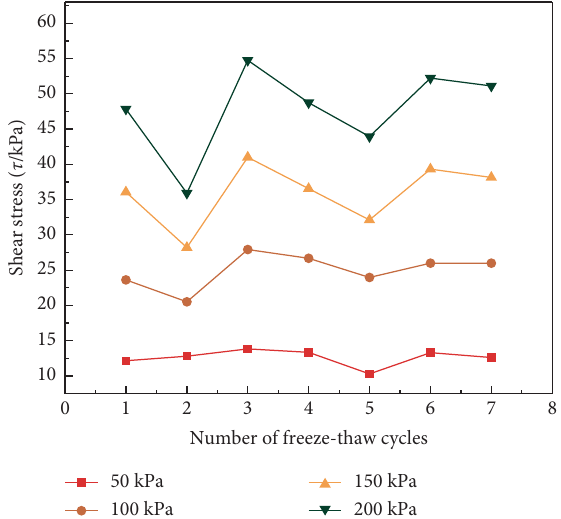
Figure 13: Relationship between shear strength and freezing- thawing cycles under different